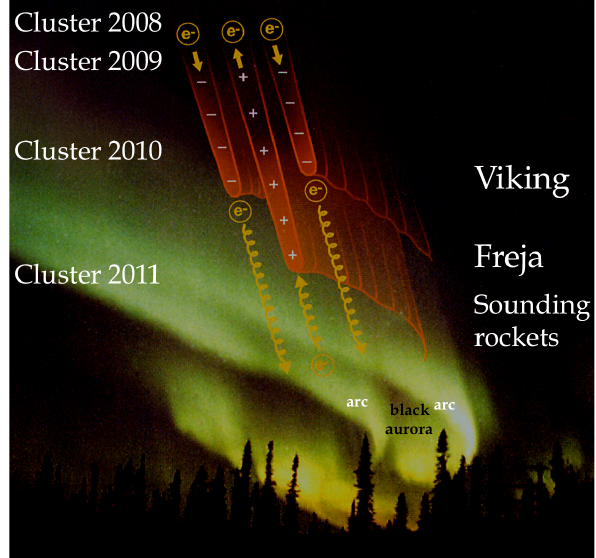
Figure 10. Auroral acceleration structures superimposed on bright arcs and black aurora. The 3 Fig. 10. Auroral acceleration structures superimposed on bright arcs altitude of Cluster during recent years as well as of previous auroral missions and rockets is 4 and black aurora. The altitude of Cluster during recent years as well indicated (adapted from Marklund et al., 2009). 5 as of previous auroral missions and rockets is indicated (adapted from Marklund,